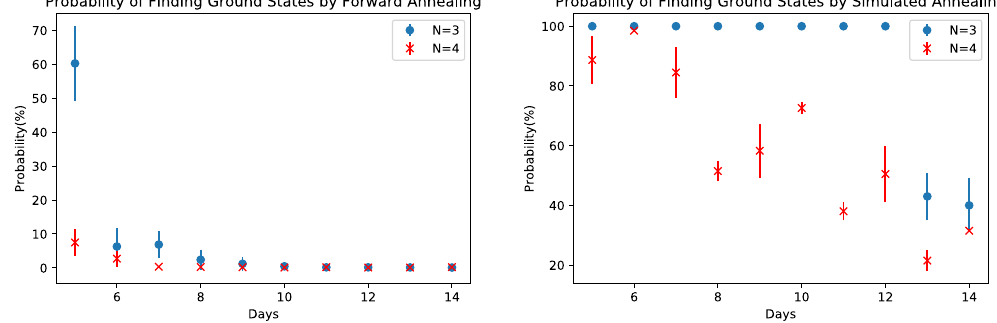
Figure 2. The probability of finding a ground state of the Hamiltonian by using D-Wave 2000Q (left) and simulate annealing (right) for (blue) = N 3 and (red) = N 4 with respect to the number of days D in the schedule. Each error bar is generated by the standard deviation (1000 samples for 10 shots for D-Wave 2000Q and 500 annealing times 10 shots for SA).